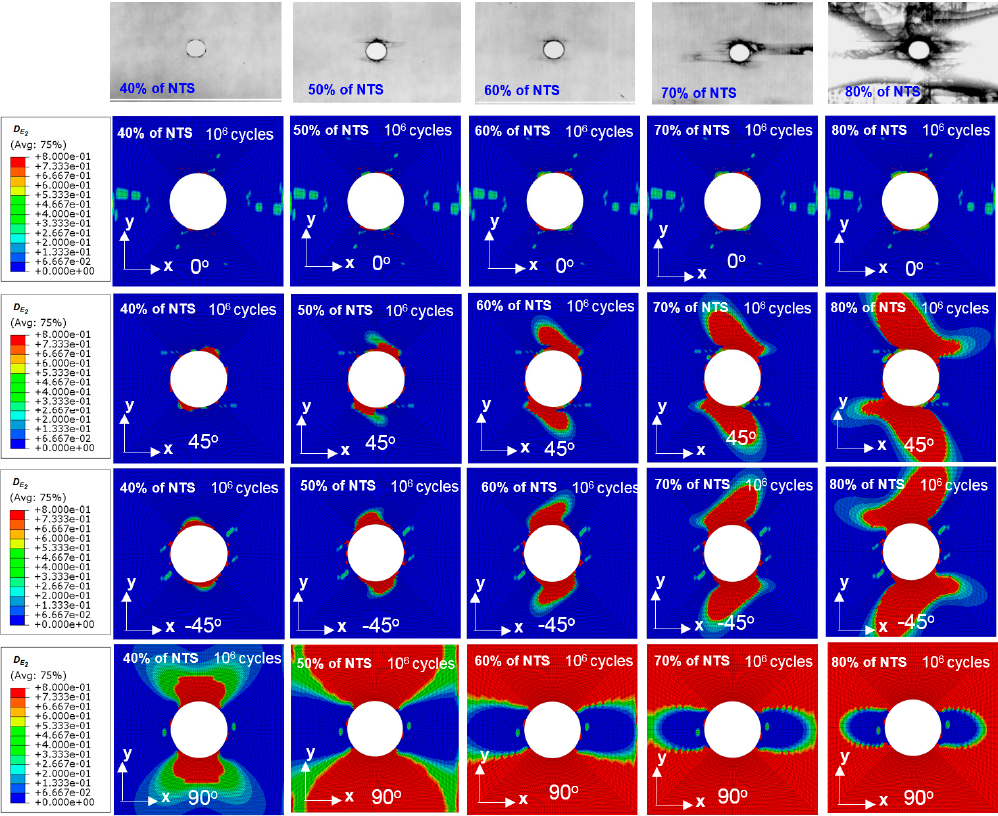
Figure 15. Reduction in stiffness G 12 in each ply of the OHT specimen after 10 6 cycles.